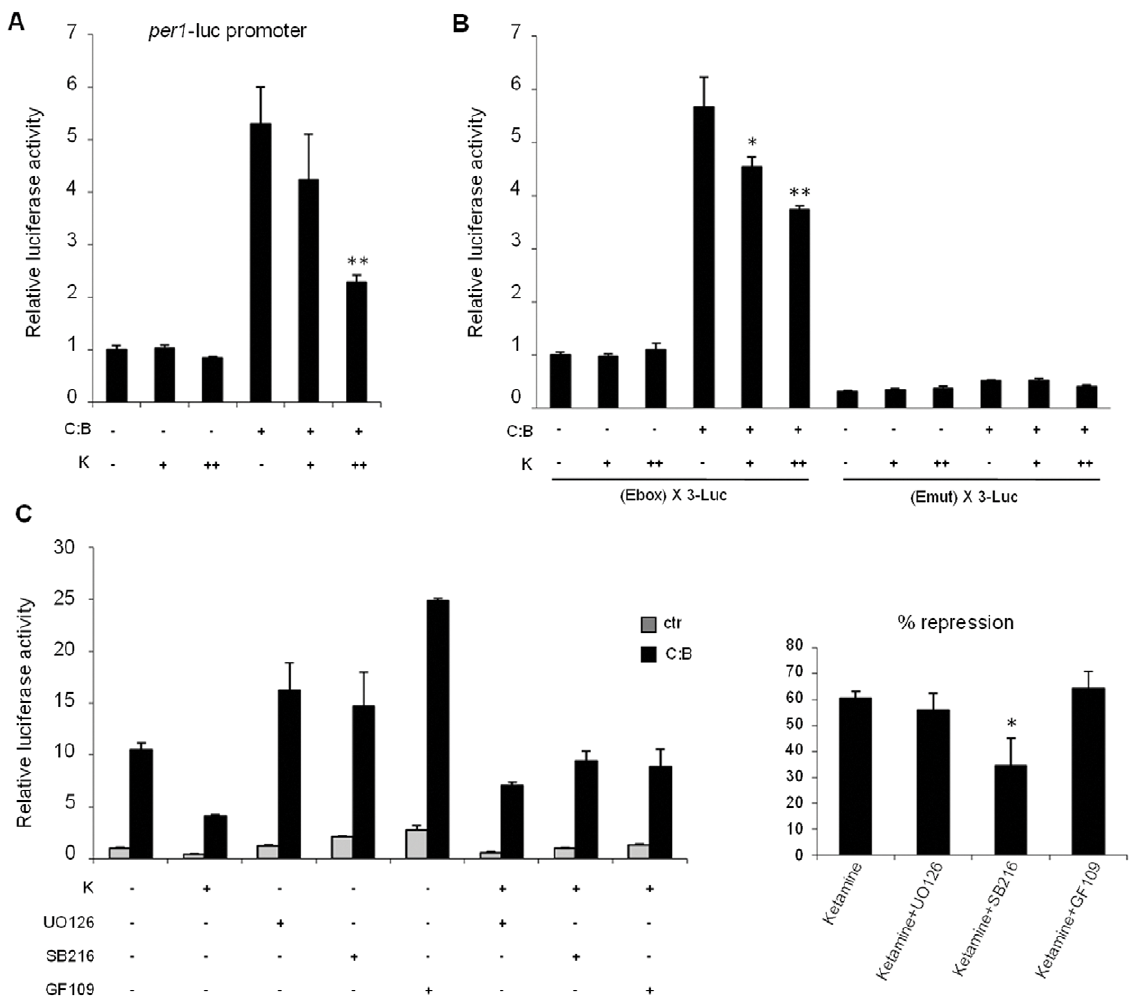
Figure 1. Ketamine treatment represses CLOCK:BMAL1 transactivation potential on the mPer1 gene promoter. (A) Effect of ketamine on CLOCK:BMAL1 dependent transcription. Vectors expressing CLOCK:BMAL1 (C:B, 25 ng each) were cotransfected with a construct containing the mPer1 promoter (pGL3-mPer1-Luc, 50 ng) in NG108-15 cells. The total DNA amount was kept constant by adding carrier plasmid DNA. After 6 hs of transfection, cells were treated with increasing amounts of ketamine (K, 18 h, + as 10 mM and ++ as 1 mM). After normalization for transfection efficiency using b -galactosidase activity, reporter gene activities were expressed relative to those of a control transfected only with non-expressing plasmids. All the values are the mean + / 2 SD (n=3); (**) p , 0.01. (B) The E box promoter element mediates ketamine repression of CLOCK:BMAL1. Experimental conditions were as in A except that reporter constructs containing three copies of the E box consensus sequence (pGL3 promoter (E box) X3 LUC) or its mutated form (pGL3 promoter (Emut) X3 LUC) were used. All values are the mean + / 2 SD (n=3); (*) p , 0.05, (**) p , 0.01. (C) Ketamine repression of CLOCK:BMAL1 involves activation of GSK3 b . Experimental conditions were as in B except that the kinase inhibitors UO126 (ERK kinase inhibitor), SB216763 (GSK3 b kinase inhibitor) and GF109203 (PKC kinase inhibitor) were applied to cells together with ketamine treatment (K, ++ as 1 mM). % of repression of CLOCK:BMAL1 transactivation with ketamine alone or ketamine with different kinase inhibitors is shown. All values are the mean + / 2 SD (n=3); (*) p ,